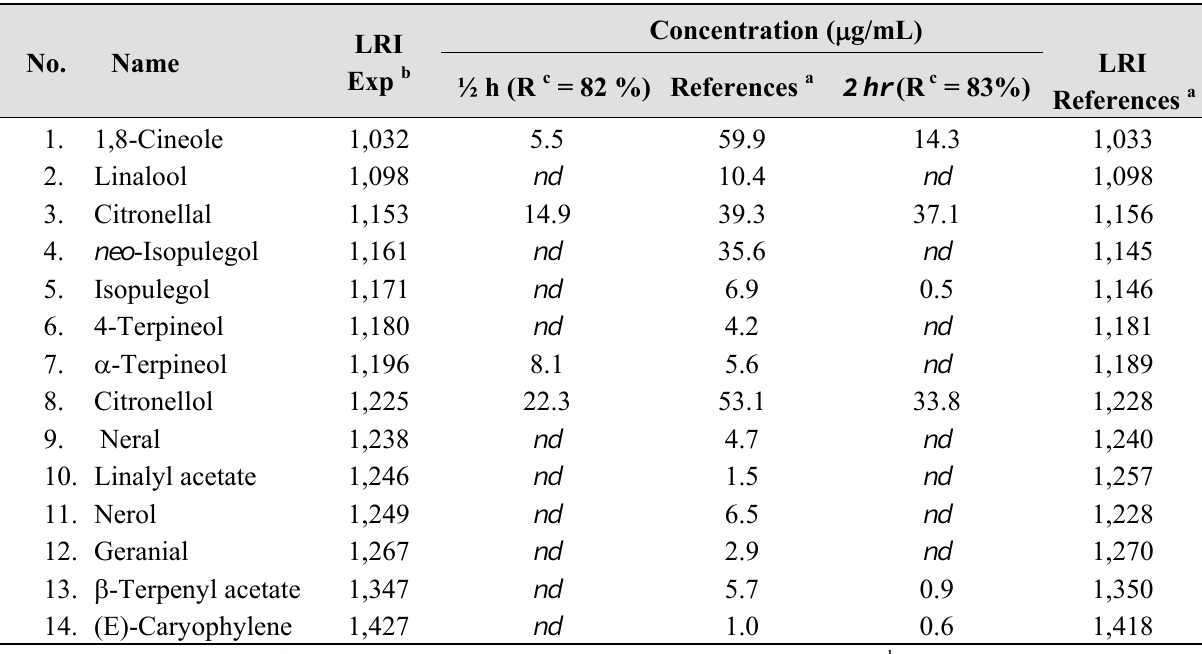
Table 5. Active volatile compounds identified in blood after inhalation of ki lemo bark essential